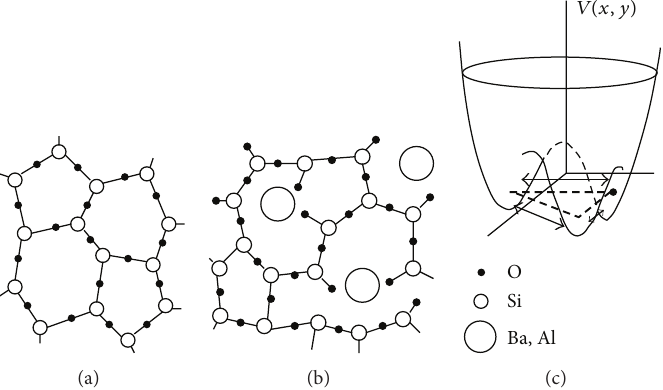
Figure 4: Two-dimensional representation of the plausible source of magnetic-field sensitive (anomalous) tunneling systems in, for example, the AlBaSiO glass. The tight vitreous-SiO 2 structure (a) is broken up by the Al- and large Ba-atoms (b), thus leaving many metal ions free to move in a 𝑛 𝑤 -minima (soft) tunneling potential, with 𝑛 ≥ 3 (c). The unbroken Si–O–Si bond dynamics, if any, is of the usual